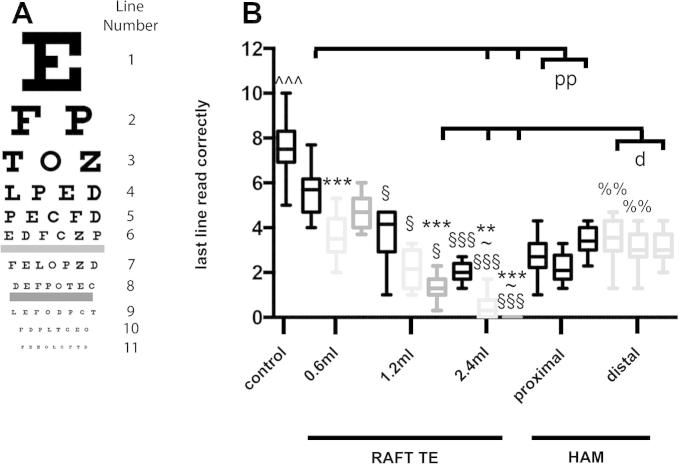
Transparency of RAFT TEs and HAM samples. A: standardized chart used in this study (left) with line numbers (right) indicated. B: RAFT TEs were produced using either 0.6 ml, 1.2 ml or 2.4 ml of 1 mg/ml collagen (black boxes), 2 mg/ml collagen (light grey boxes) or 3 mg/ml collagen (mid grey boxes). Masked observers assessed transparency of the different RAFT TEs, HAM samples (far right), and control well (far left). Data are averages from 14 masked observers: central line represents median, box represents first and third quartiles, and whiskers represent minimum and maximum. ^^^p < 0.005 compared to all RAFT TE and HAM samples. §p < 0.05, §§§p < 0.005 compared to RAFT TEs produced using the same concentration of collagen but 0.6 ml volume. ∼p < 0.05 compared to RAFT TEs produced using the same concentration of collagen but 1.2 ml volume. ∗∗p < 0.01, ∗∗∗p < 0.005 compared to RAFT TEs produced using the same volume of collagen but 1 mg/ml collagen. %%p < 0.01 compared to proximal HAM samples isolated from the same donor. d p < 0.05 distal HAM samples compared to RAFT TE. pp p < 0.01 proximal HAM samples compared to RAFT TE.